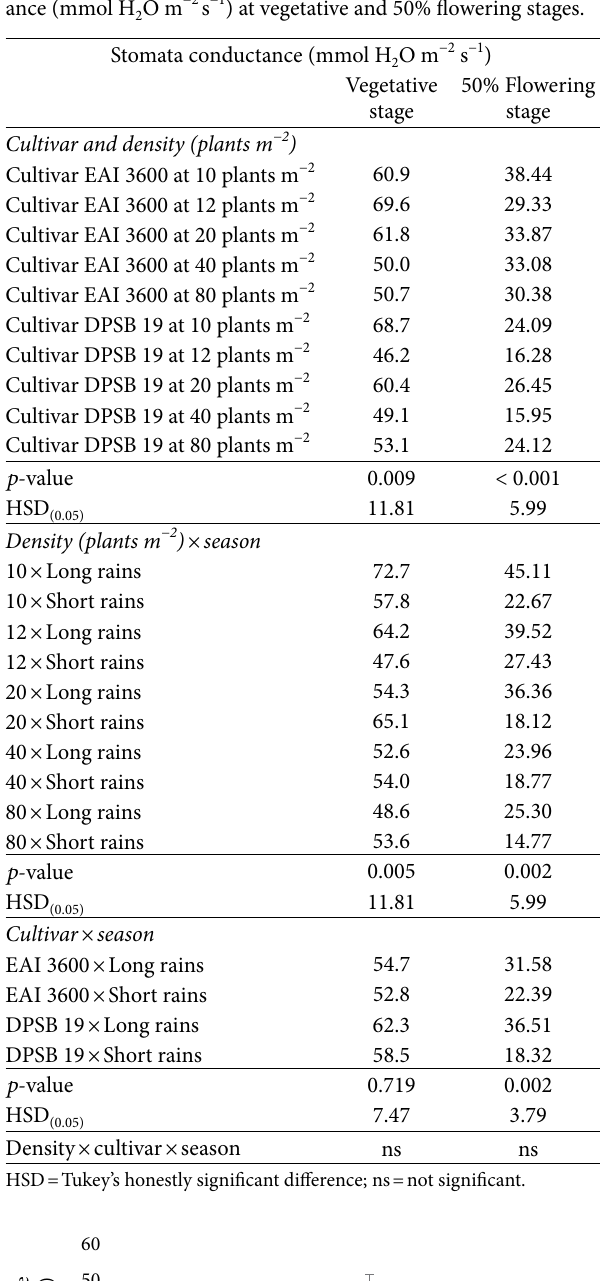
Table 4: Effect of plant density and cultivar on stomata conduct-